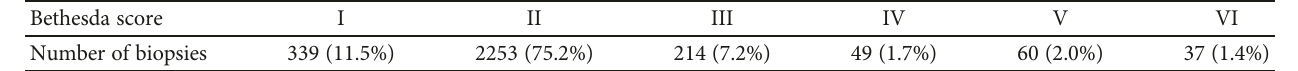
Table 1: The distribution of Bethesda score among 2955 fi ne needle aspiration biopsies.